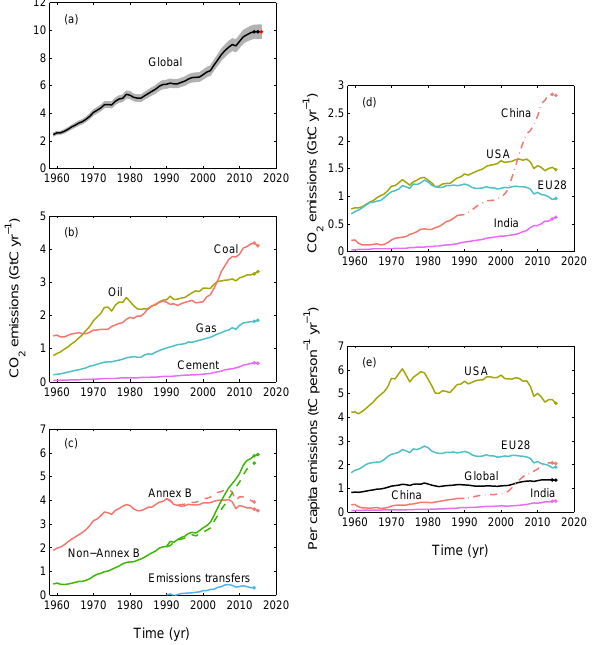
Figure 5. CO 2 emissions from fossil fuels and industry for (a) the globe, including an uncertainty of ± 5% (grey shading), the emis- sions extrapolated using BP energy statistics (black dots), and the emissions projection for year 2016 based on GDP projection (red dot). (b) Global emissions by fuel type, including coal (salmon), oil (olive), gas (turquoise), and cement (purple), and excluding gas flaring which is small (0.6% in 2013). (c) Territorial (solid line) and consumption (dashed line) emissions for the countries listed in Annex B of the Kyoto Protocol (salmon lines; mostly advanced economies with emissions limitations) vs. non-Annex B countries (green lines); also shown are the emissions transfer from non-Annex B to Annex B countries (light-blue line). (d) Territo- rial CO 2 emissions for the top three country emitters (USA – olive; China – salmon; India – purple) and for the European Union (EU; turquoise for the 28 member states of the EU as of 2012). (e) Per capita emissions for the top three country emitters and the EU (all colours as in panel ( d ) and the world (black). In (b–e) , the dots show the data that were extrapolated from BP energy statistics for 2014 and 2015. All time series are in GtCyr − 1 except the per capita emissions (e) , which are in tonnes of carbon per person per year (tCperson − 1 yr − 1 ). Territorial emissions are primarily from Boden and Andres (2016) except for national data for the USA and EU28 for 1990–2014, which are reported by the countries to the UNFCCC as detailed in the text, and for China from 1990, which are esti- mated here from BP energy statistics (the latter shown as a dash- dot line); consumption-based emissions are updated from Peters et al. (2011a). See Sect. 2.1.1 for details of the calculations and data